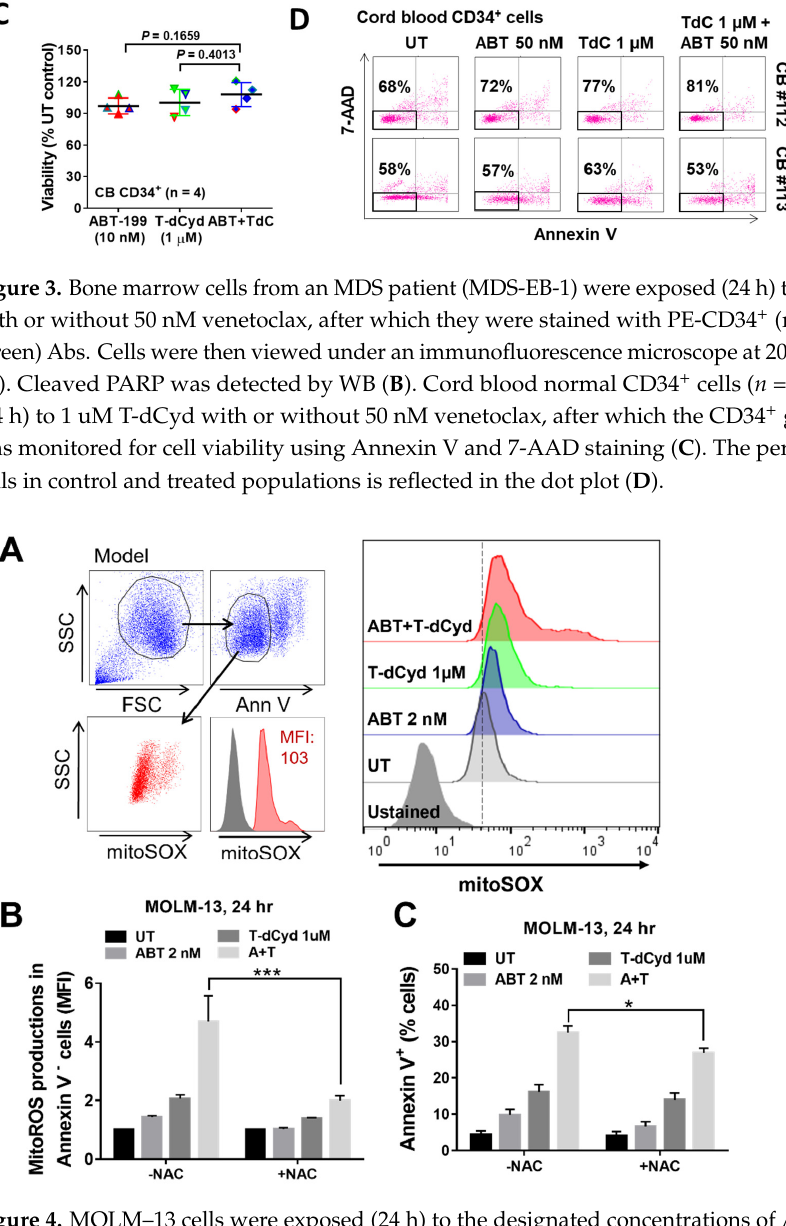
Figure 4. MOLM–13 cells were exposed (24 h) to the designated concentrations of ABT and T–dCyd, after which mitochondrial ROS in the viable cell population was monitored by FCM and MFI ( A ). ( B ) Effects of NAC on mitoROS ( B ) and viability ( C ) following the same exposure. For p values, * = <0.05; *** = <0.001. Expression of Nuclear Anti-Oxidant Proteins and BCL-2